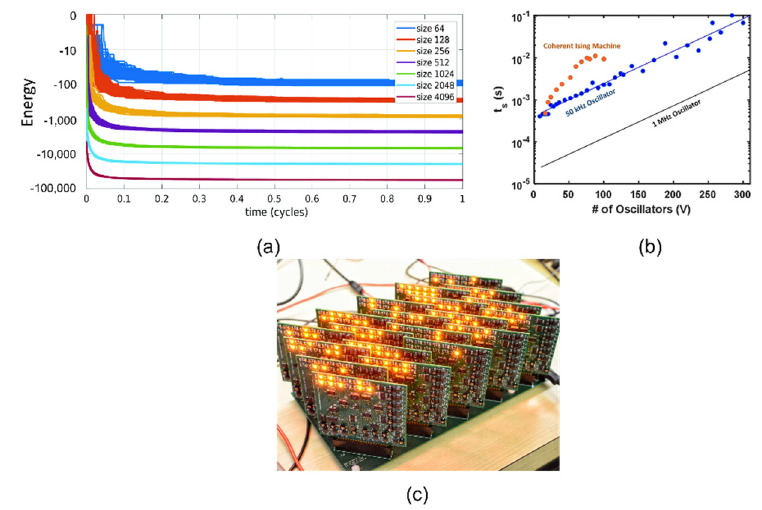
Figure 11. ( a ) Relationship between the convergence time of the Ising function and the size of the oscillator network [18]; ( b ) relationship between the solution time of the oscillator network and the size and oscillation frequency [41]; ( c ) 240 LC oscillator network [42]. Compared with LC oscillators, ring oscillators can easily achieve higher working frequencies and can be easily integrated. Ahmed et al. fabricated a programmable network consisting of 560 coupled ring oscillators and successfully realized a fully integrated chip- scale Ising machine [3,43]. Each oscillator and its adjacent oscillators were negatively cou- pled using a set of anti-parallel connected inverters (Figure 12a), and the coupling coeffi- cient could be easily adjusted by the control signal for real-time programming, which en- ables it to solve a variety of max-cut problems with different sizes. Experiments showed that the success rate of this Ising machine in solving max-cut problems was as high as 82– 100%. Compared with commercial software, the solving speed was 10 4 –10 6 times faster, while the power consumption of the entire Ising machine was only 23 mW, corroborating its great potential for practical applications. Recently, Moy et al. reported a 1968-node coupled King’s graph ring oscillator–based Ising machine with five-level coupling strengths [44]. Here, the programmability was im- plemented by the transmission gates. Each gate could be separately turned on/off to ena- ble the five coupling states. In addition to using inverters, the negative coupling weight could also be realized by the cross-coupling configuration because of the 180° phase dif- ference between the adjacent nodes of the ring oscillators (Figure 12b). This Ising chip has